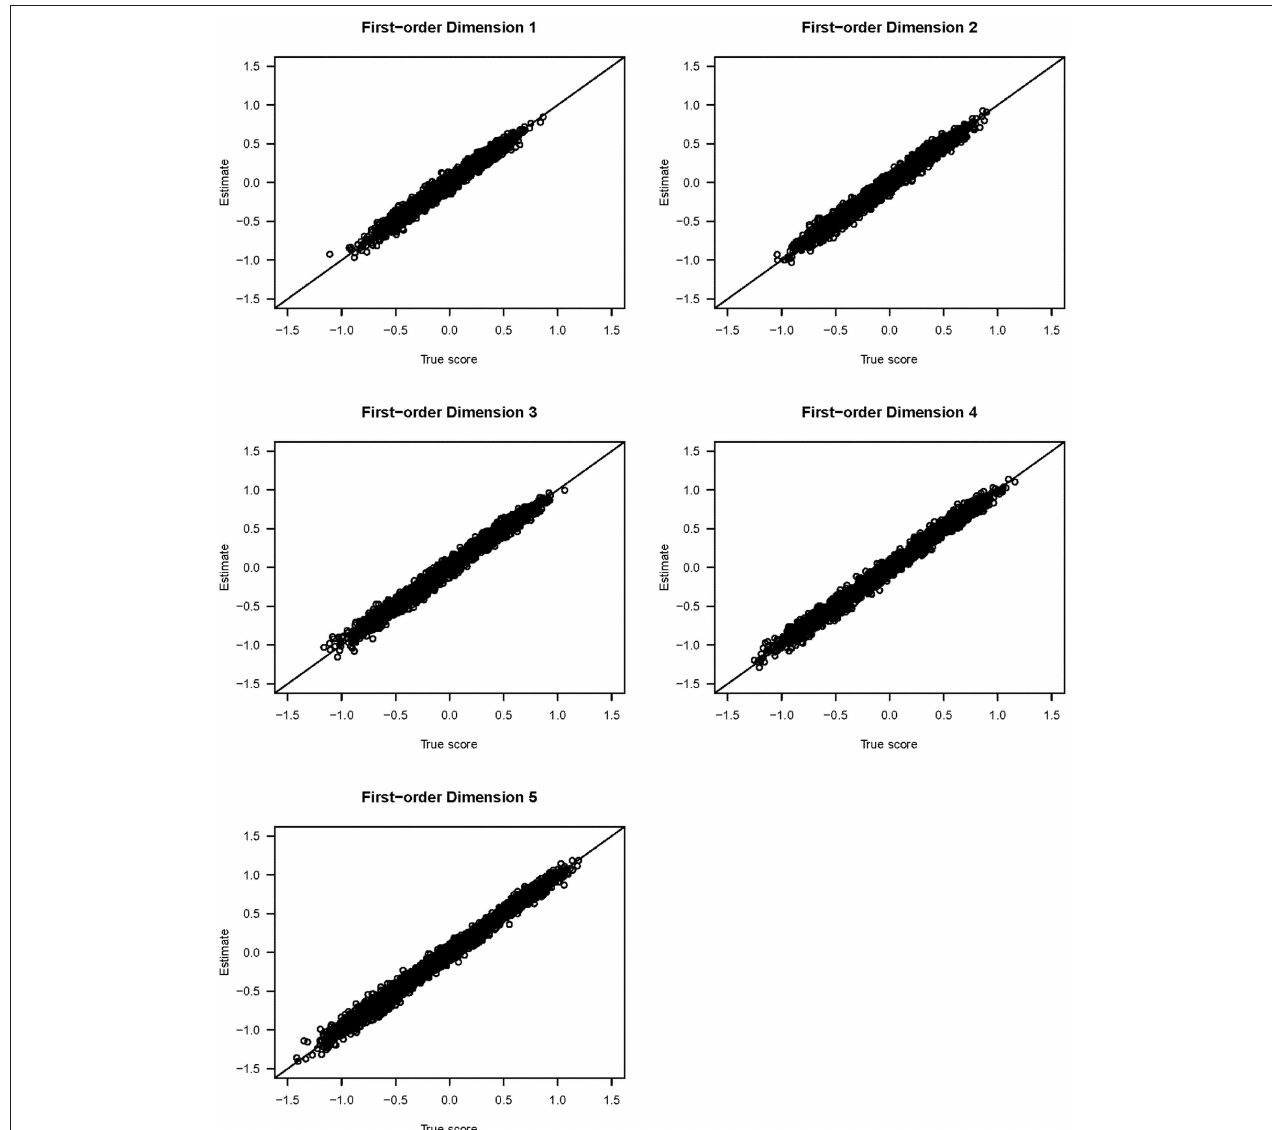
FIGURE 3 | Scatter plots of the true and estimated first-order latent trait scores from the simulation